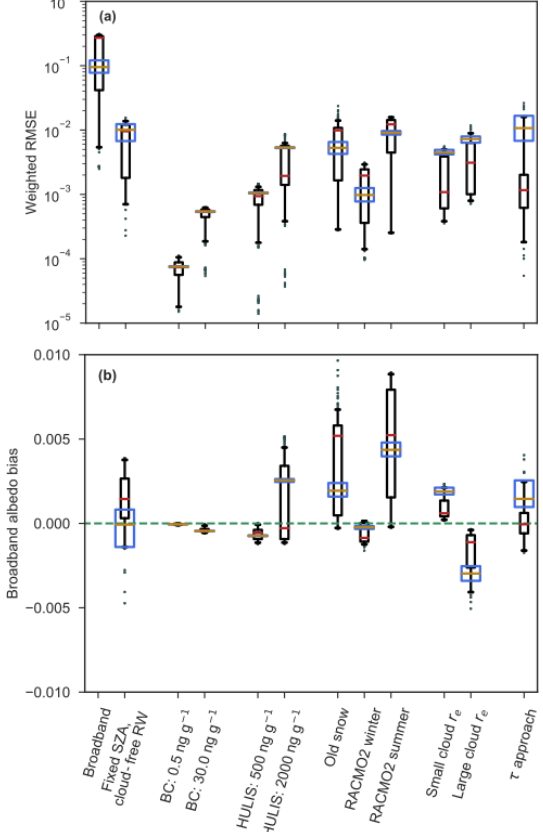
Figure 8. (a) Weighted RMSE of the broadband albedo method, fixed SZA, cloud-free RW method, BC, HULIS and snow profiles. For each variable, the weighted RMSE is calculated as a func- tion of SZA for clear-sky conditions for diffuse radiation, IWV and SZA for direct radiation and as a function of SZA, LWP and IWP for overcast conditions. Together, they form an ensemble of atmospheric conditions, with the red line indicating the median, the box showing the 25th to 75th percentiles and the whiskers show- ing the 5th to 95th percentiles. The dots show the outliers beyond the whiskers. The blue box shows the 25th to 75th percentiles for cloudy conditions if limited to LWP and IWP < 1.0kgm − 2 , with the dark orange line indicating the median. Low and high concen- trations of BC and HULIS are considered. In addition, a hypotheti- cal old snow profile is assessed, which consists of four layers with a density of 350, 400, 500 and 700kgm − 3 and a SSA of 10, 5, 1 and 0.1m 2 kg − 1 . The weighed RMSEs of typical winter and sum- mer snow profiles are assessed as well. These profiles are extracted from RACMO2 and consist of many layers. The summer profile includes the impact of melt in the upper snow layers. The impact of cloud effective radius r e is evaluated for small and large values, i.e., r e , ice , r e , liquid = 15, 5 and 30, 30µm, respectively. Finally, the τ approach is shown, as is described in Sect. 3.5. Only cloudy con- ditions are considered for the cloud effective radius and τ approach. (b) The broadband albedo bias is shown for the same variables. The bias of the broadband albedo method is 0 by construct and therefore left